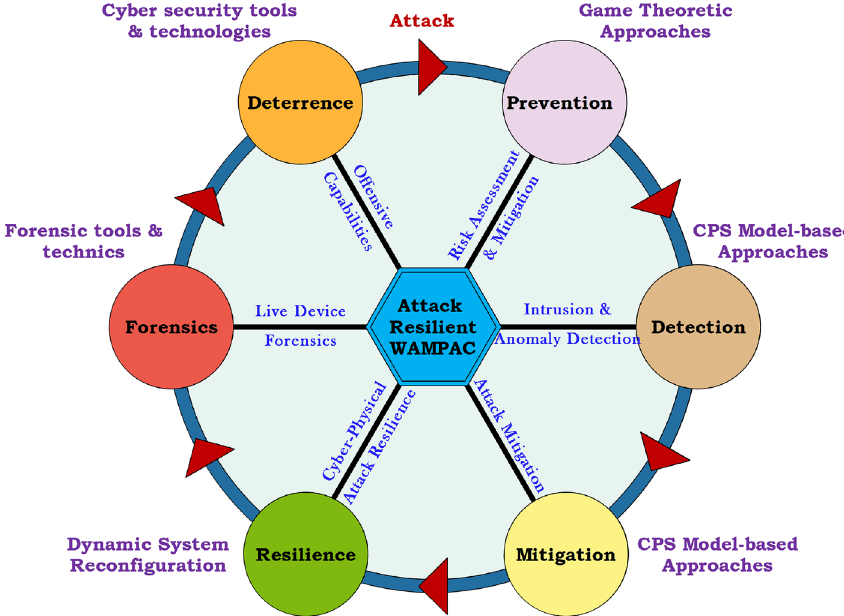
Figure 12. Attack-resilient WAMPAC for the power grid.